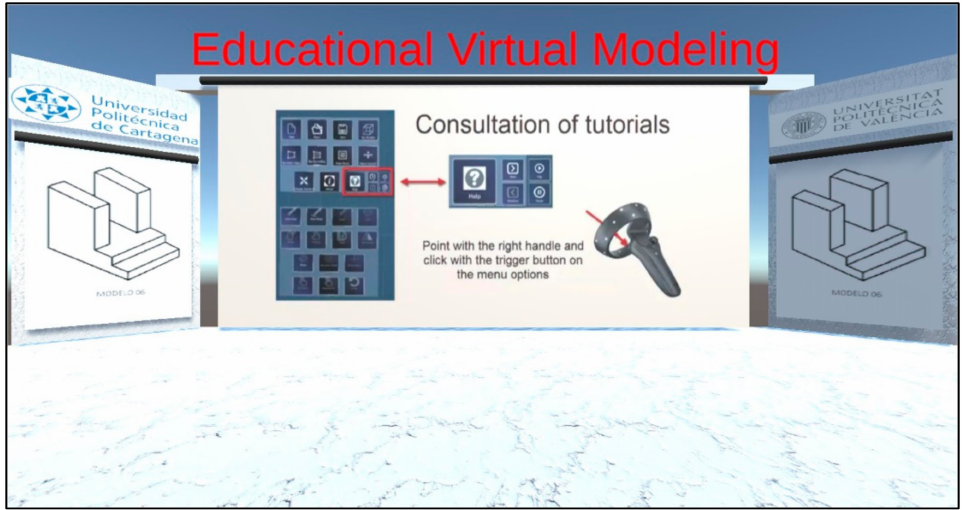
Figure 4. User workspace in the virtual